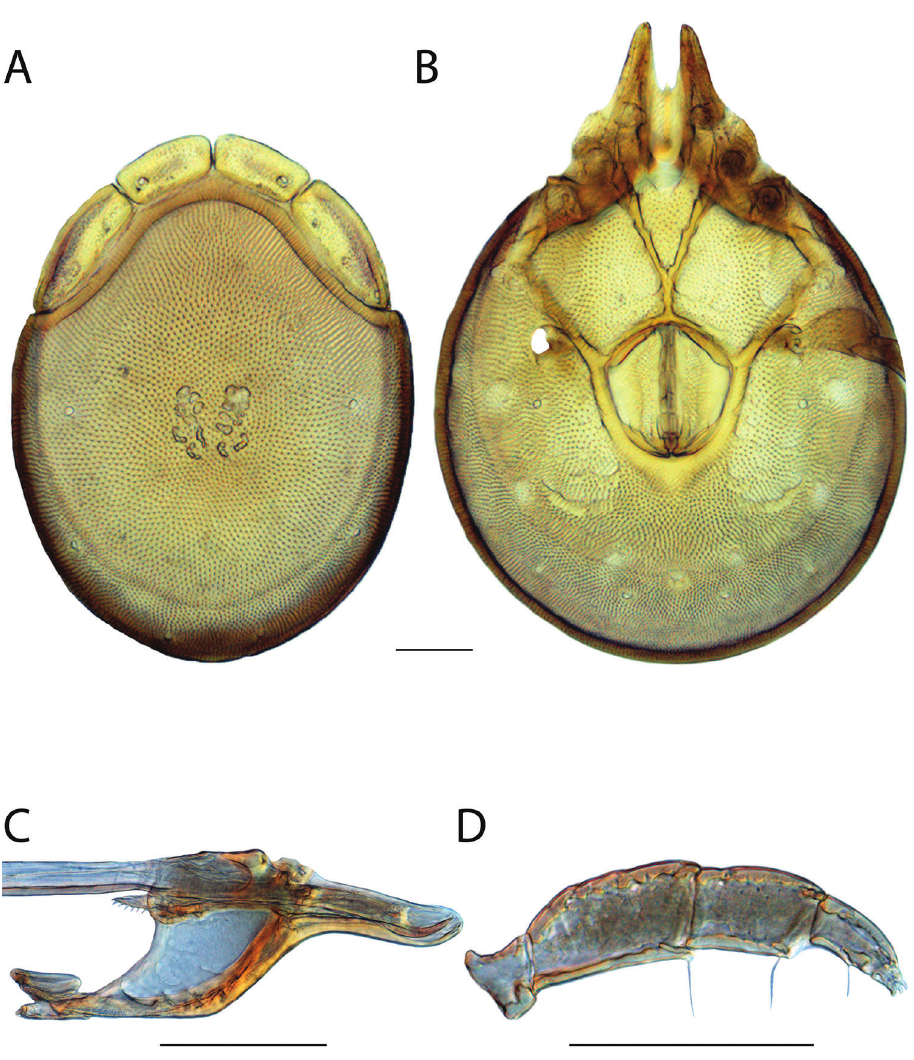
Figure 121. Torrenticola kurtvietsi female: A dorsal plates B venter (legs removed) C subcapitulum D pedipalp (setae not accurately depicted). Scale = 100 µm.